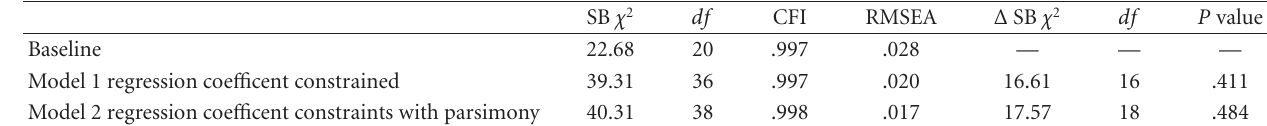
Table 4: Goodness of fit summary for model